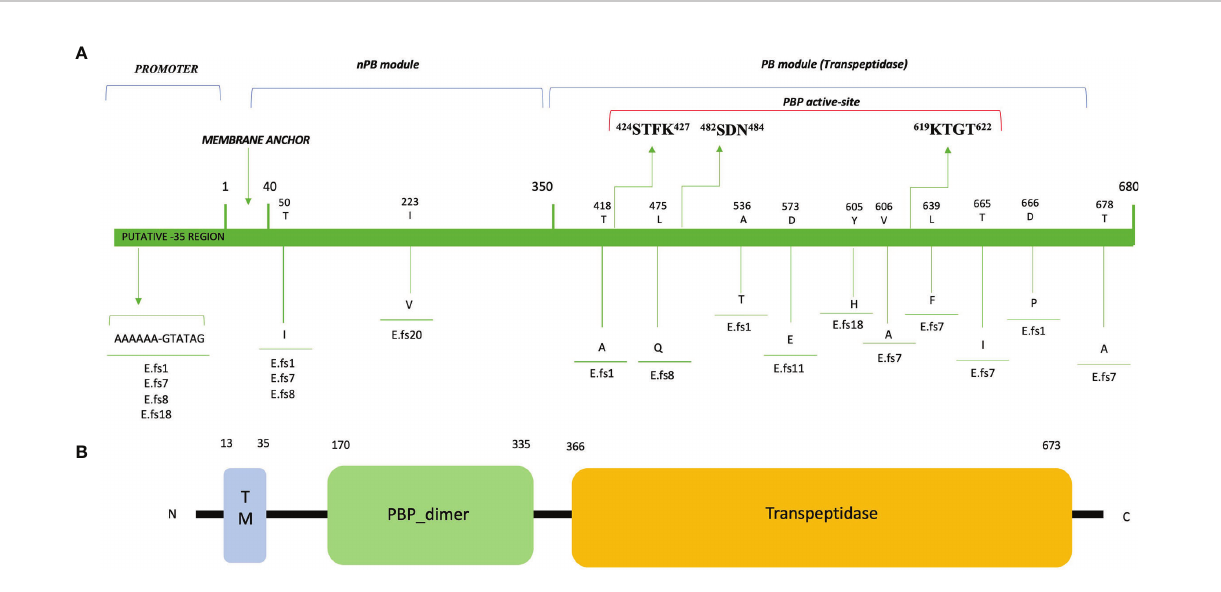
FIGURE 2 | Amino acid substitutions and domain architecture of PBP4 of E faecalis clinical isolates. GenBank accession no. from OM032878 to OM032884. The numbers above the diagrams indicate residue numbers of the domain boundaries in the proteins. (A) Non-Penicillin Binding module (nPB); Penicillin Binding module (PB); TM, transmembrane helix region. 424 STFK 427 , 482 SDN 484 and 619 KTGT 622 : catalytic-site motifs (STFK 424 includes the catalytic serine S 424 ). (B) The domain architecture of PBP4 of E faecalis ATCC 47077 (OG1RF) was analyzed using SMART (Simple Modular Architecture Research Tool; http://smart.embl-heidelberg.de/) and reported in a simpli fi ed